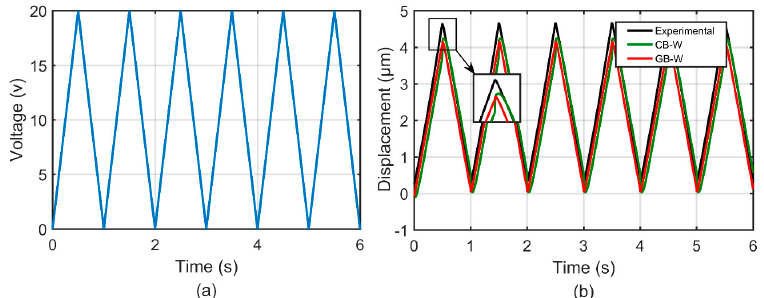
Figure 11. Time histories of: ( a ) A waveform of input excitation signal with the amplitude of 20 and ( b ) the measured and simulation results predicted by the GB–W model and CB–W model.